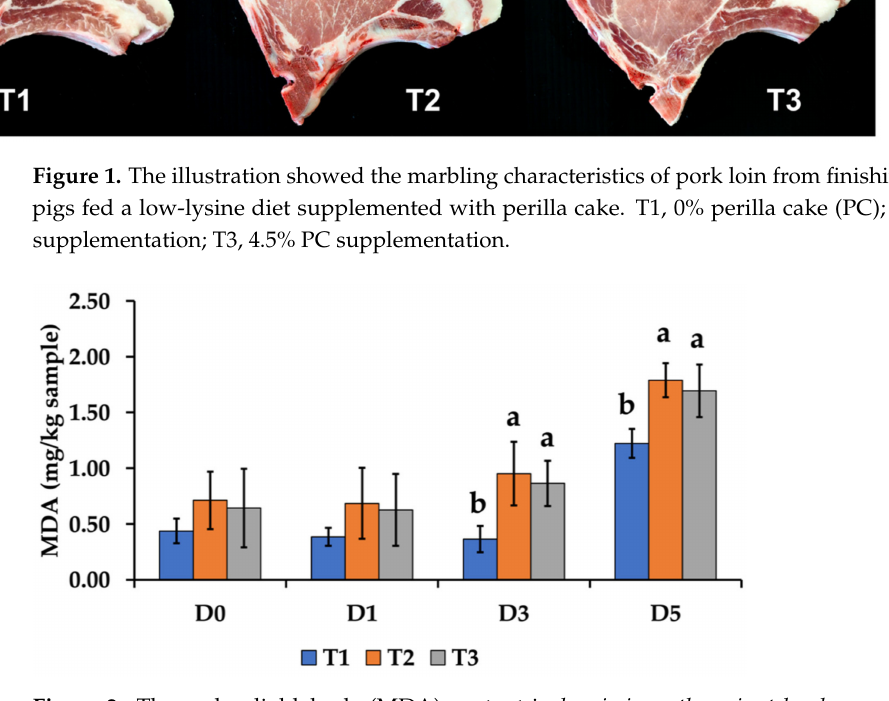
Figure 2. The malondialdehyde (MDA) content in longissimus thoracis et lumborum muscle from finishing crossbred pigs fed a low-lysine diet supplemented with perilla cake. a, b Different letters within the same row indicate a statistically significant difference ( p < 0.05). T1, 0% perilla cake (PC); T2, 2.5% PC supplementation; T3, 4.5% PC supplementation; SEM, standard error of the